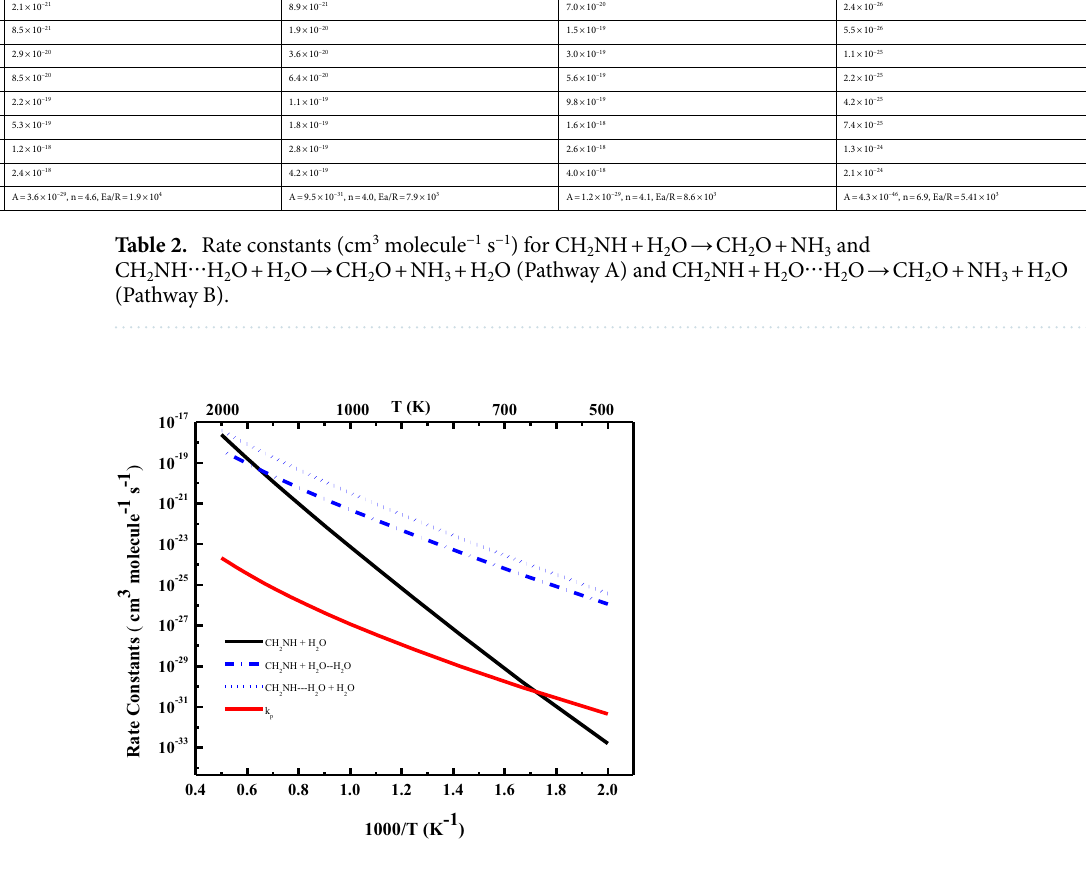
Figure 6. Rate constants for the reaction of methylenimine with one-water and two-water molecules. Dash lines correspond to reaction without water-concentration. It should be noted that these are infinite pressure limit rate constants, which are assumed to be valid from the range T ≥ 300 K, and p ≥ 1